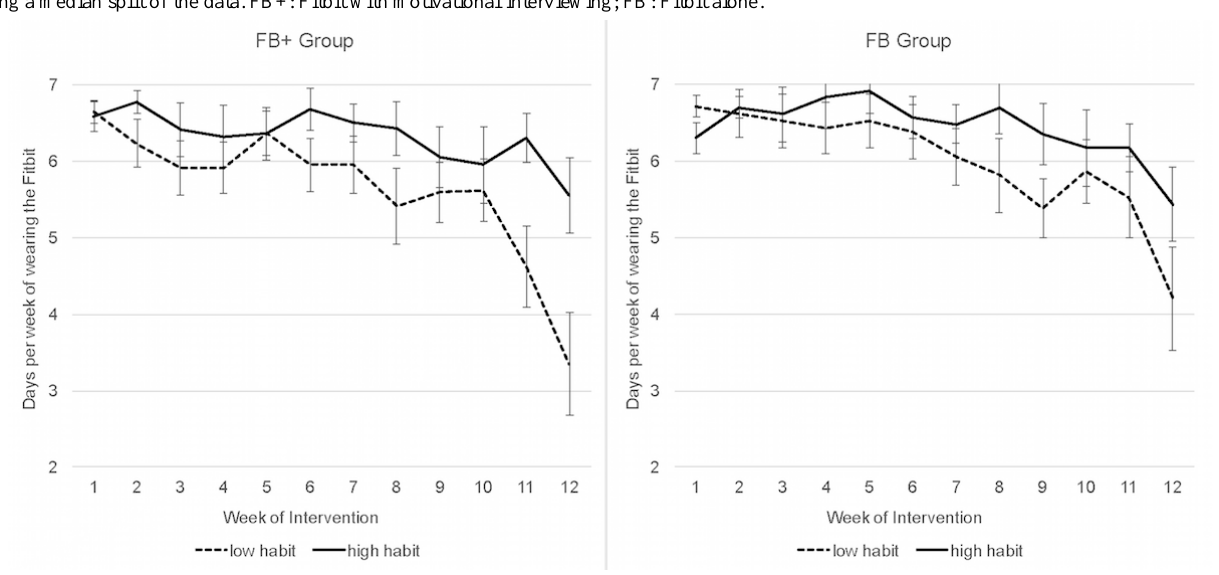
Dependent variables: percent change across the interventionIndependent variables